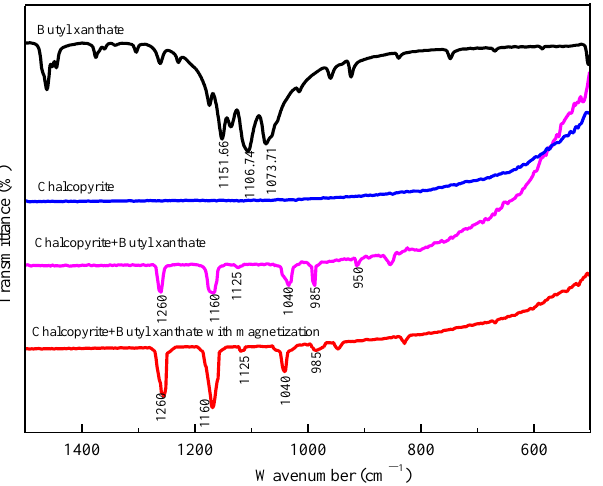
Figure 9. Infrared spectra for butyl xanthate, chalcopyrite, chalcopyrite+ butyl xanthate, and chal- copyrite+ butyl xanthate with magnetization.